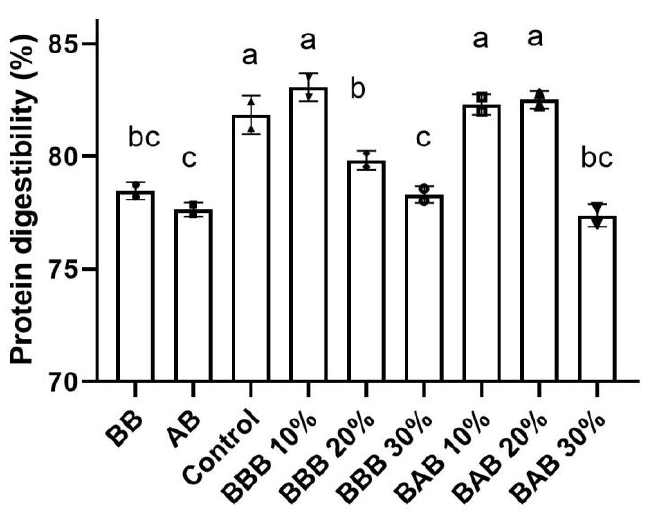
Figure 1. Protein digestibility of black bean, ayocote bean and breads. BB: Black bean flour; AB: Ayacote bean flour; BBB Bread with black bean; BAB: Bread with ayacote Ayacote bean flour; BBB Bread with black bean; BAB: Bread with ayacote beans.